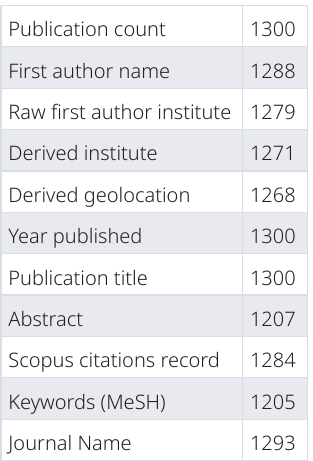
Table 3. Counts of completeness of the augmented metadata fields. The values are taken from the coverage report web page generated by the